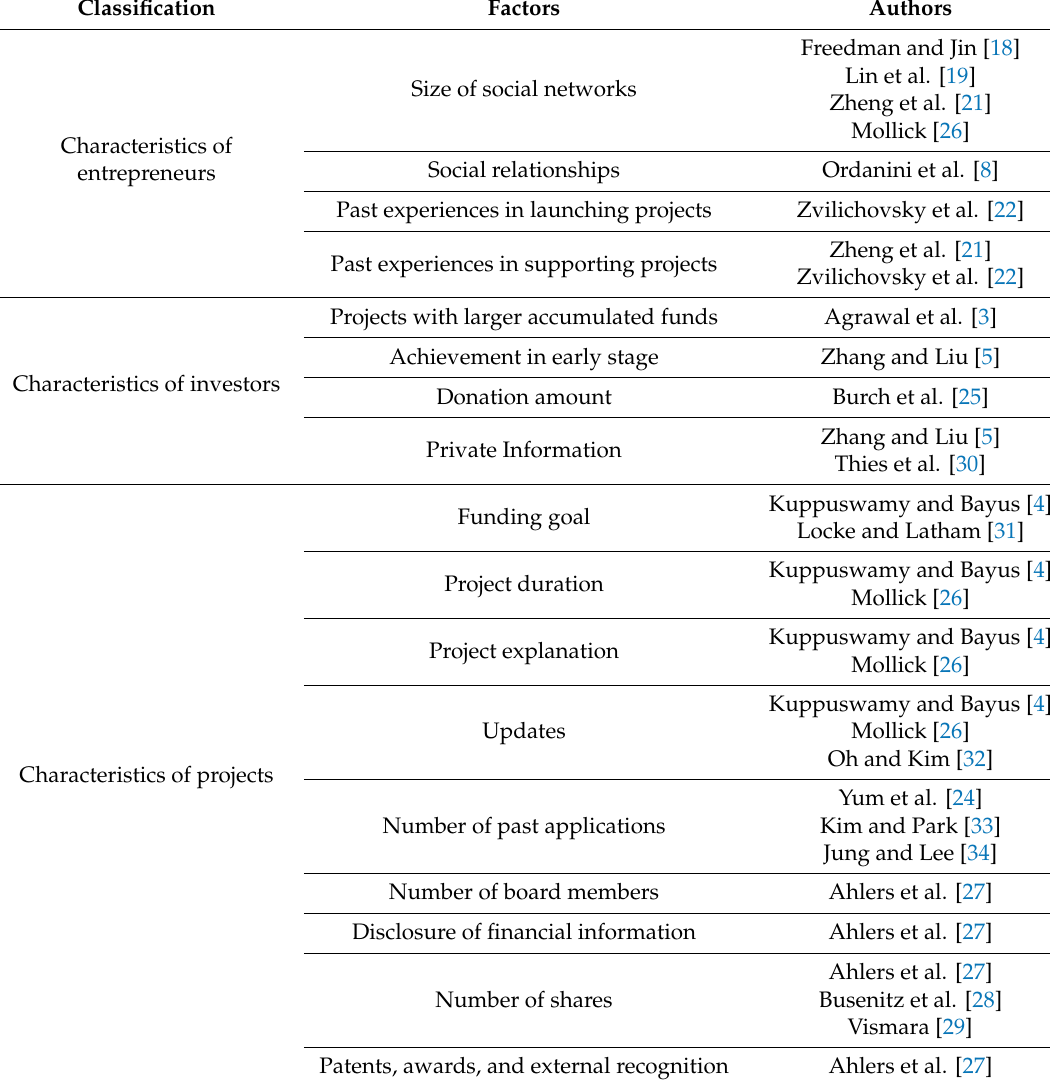
Table 2. Prior research on the determinants of successful